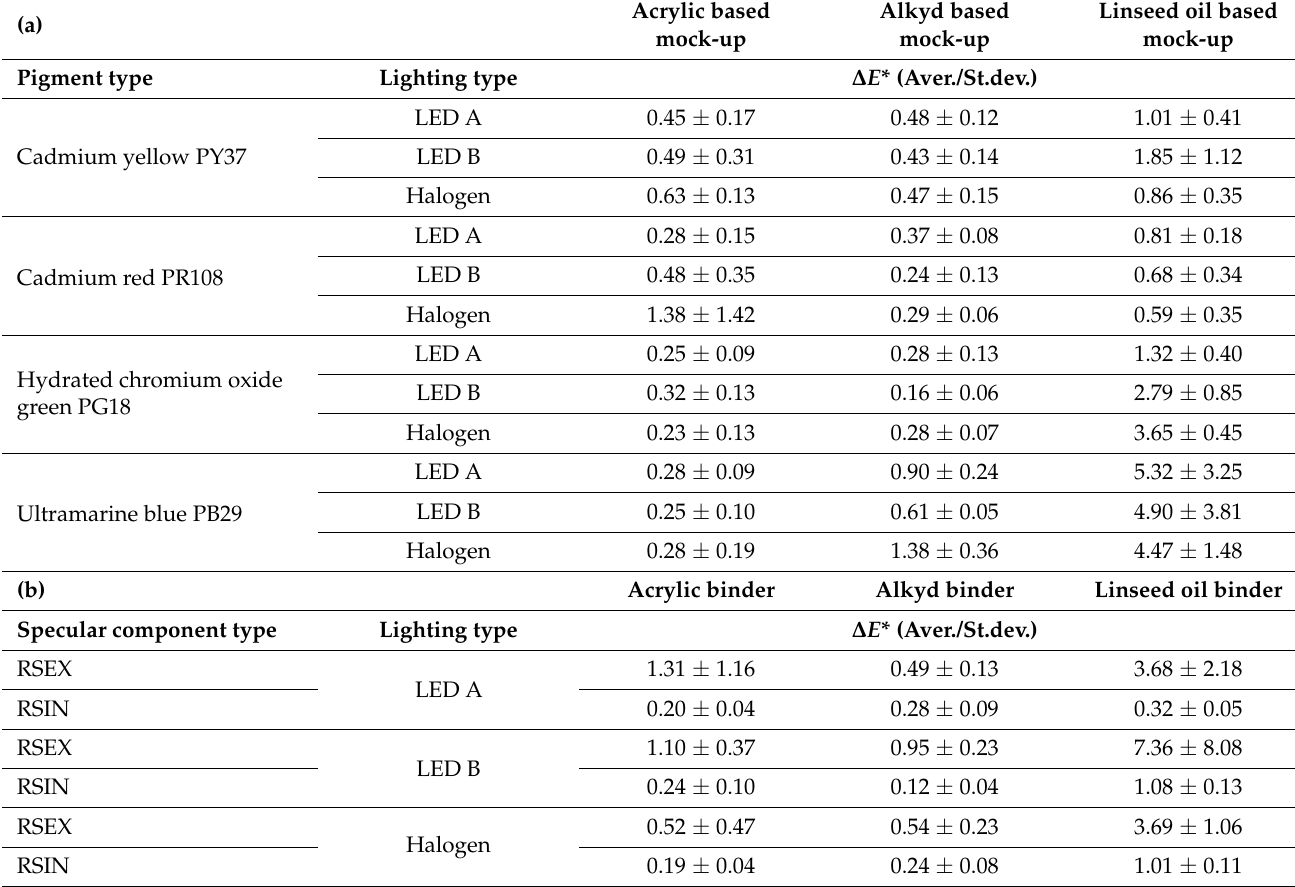
Table 1. Shifts in total colour ( ∆ E * ab 1976) of the 5000 h accelerated light aged (LED A—420 nm, LED B—460 nm, and Halogen—halogen lamp) ( a ) acrylic, alkyd, and linseed oil-based mock-ups and ( b ) binders, with their averages (Aver.) and standard deviations (St.dev.) values obtained with colour measurements [30]. The listed values of the binders without pigments were obtained with the specular component excluded (RSEX) but also included (RSIN) because of the shiny surface of the samples.